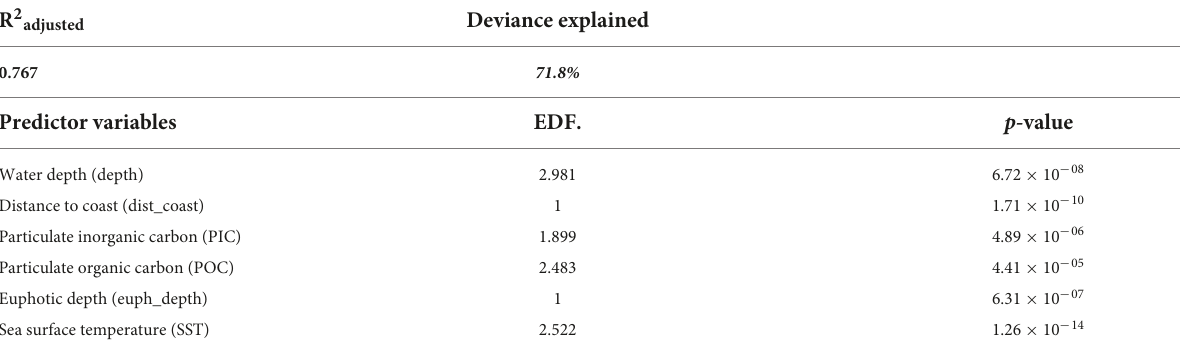
TABLE 3 Summary of the explanatory power of the six environmental variables used to predict olive ridley turtle presence in the ETP based on the best general additive model (GAM 16 , see Table 2 ); EDF are the estimated degrees of